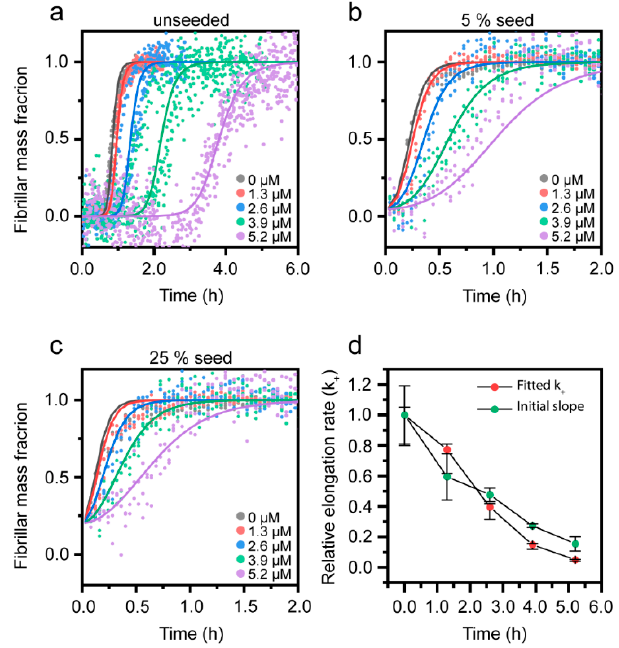
Figure 5. Fitting of the A β (1-42) aggregation kinetics in the presence of Cu 2 + at pH 8.0 to mathematical models of amyloid formation. ( a – c ) Normalized kinetic profiles of 2.6 µ M A β (1-42) at pH 8.0 corresponding to the data in Figure 4. Solid lines are the global fits to data using a model for Cu 2 + -dependent variation in the elongation rate constant (k + ). ( d ) Relative change in the elongation rate constant (k + ) determined from the fitting of the data in ( a – c ) compared to the relative rate determined via the linear approximation of the initial slope at 25% seeds in Figure 4e. All the rate constants are relative to that of 2.6 µ M of A β (1-42) in the absence of Cu 2 +